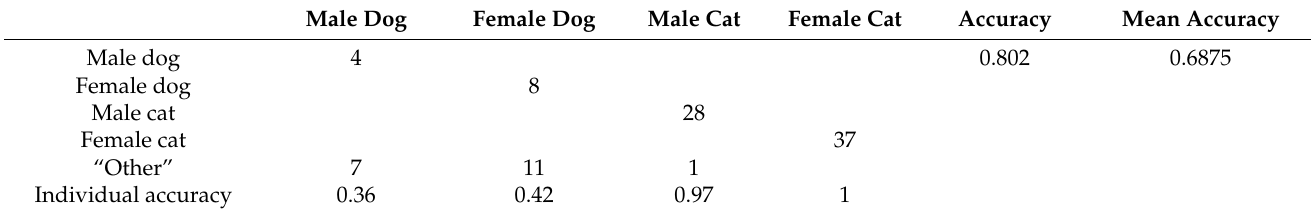
Table 14. The performance of Yolov3 majority voting for multi-classification.